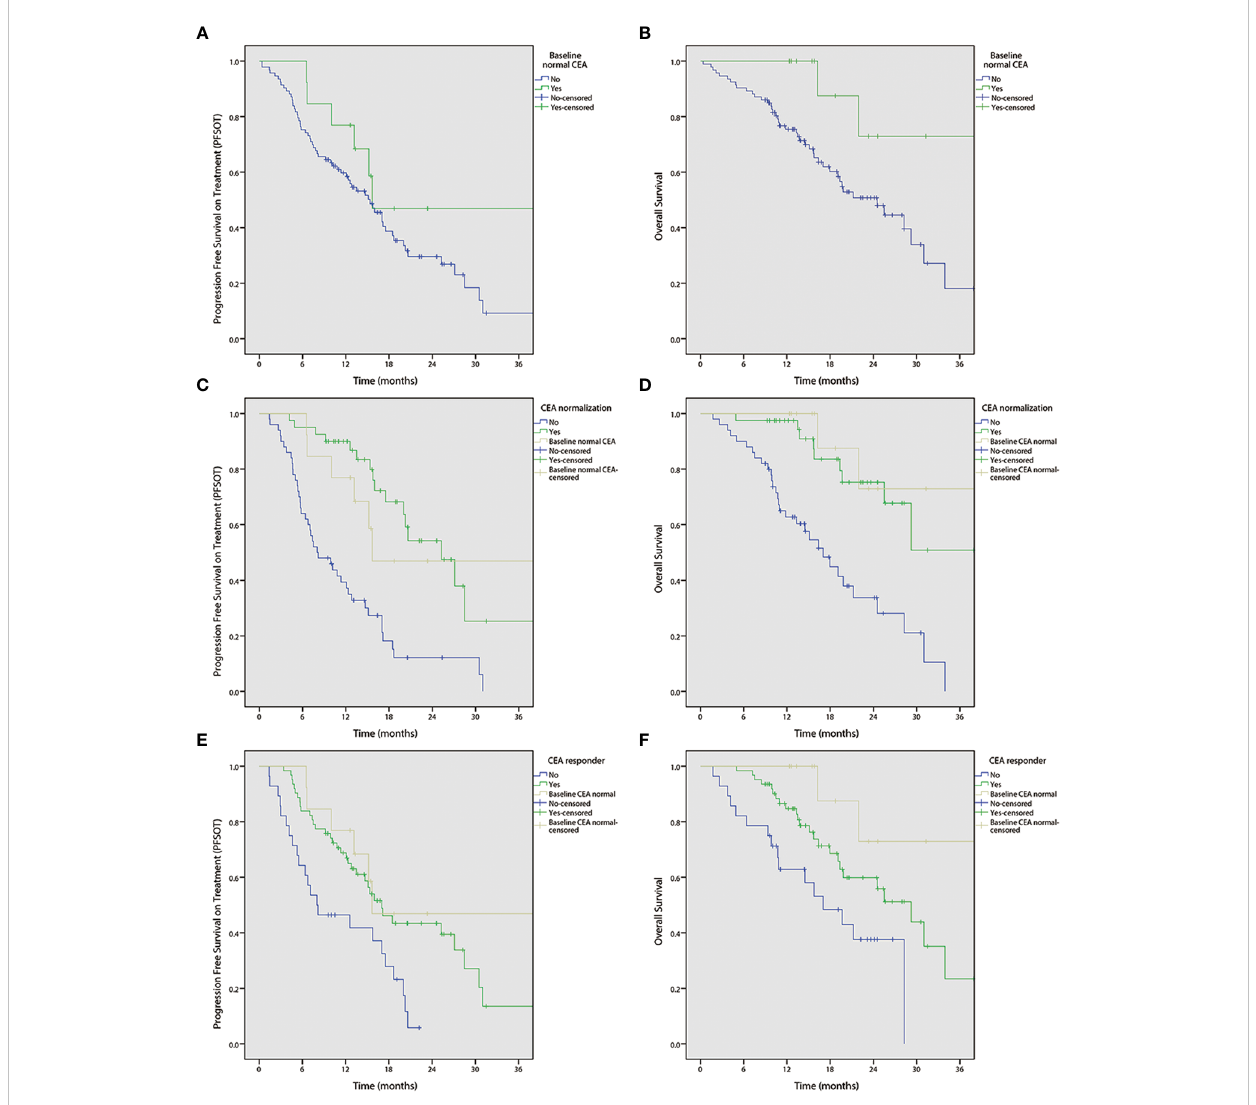
FIGURE 2 Kaplan-Meier curves of progression free survival on treatment (PFSOT) and overall survival (OS) by carcinoembryonic antigen (CEA) kinetics. (A) PFSOT by baseline normal CEA, (B) OS by baseline normal CEA. (C) PFSOT by CEA normalization. (D) OS by CEA normalization. (E) PFSOT by CEA responder. (F) OS by CEA